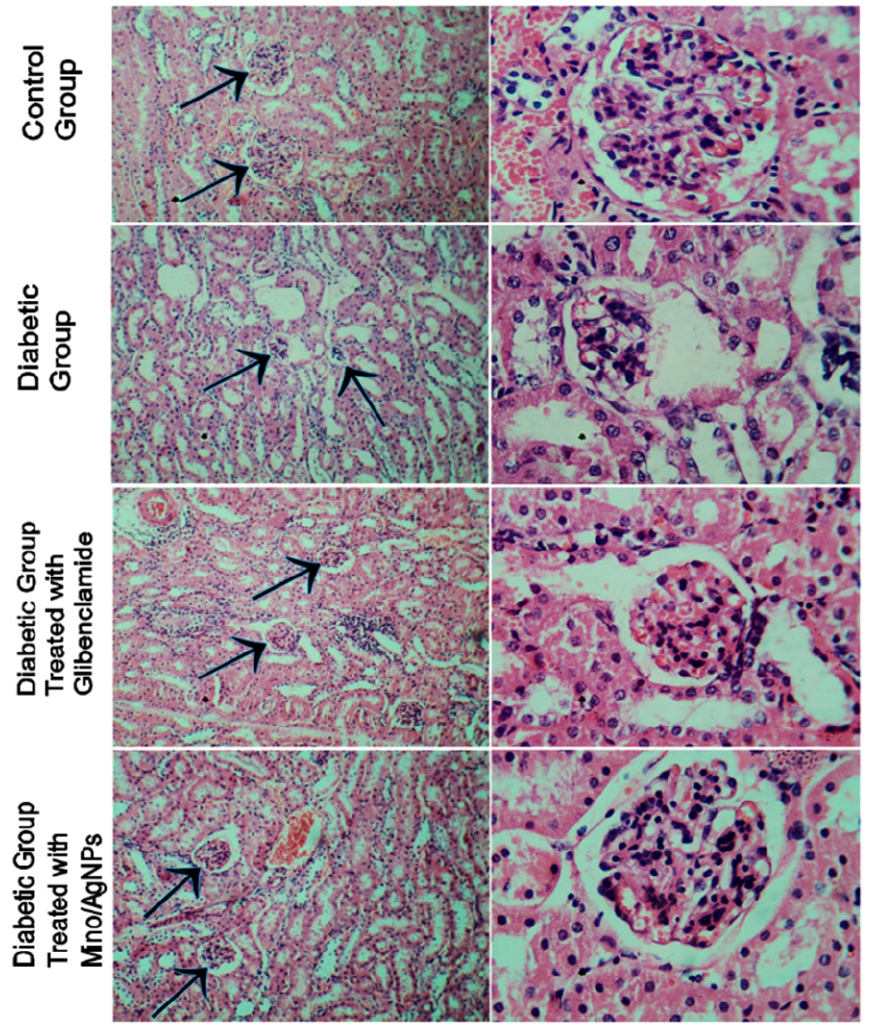
Figure 12. Histopathology of the kidney sections of various study groups (arrowhead pointing towards the glomerulus and urinary space of